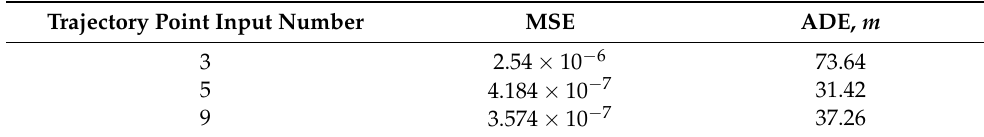
Table 4. Model evaluation